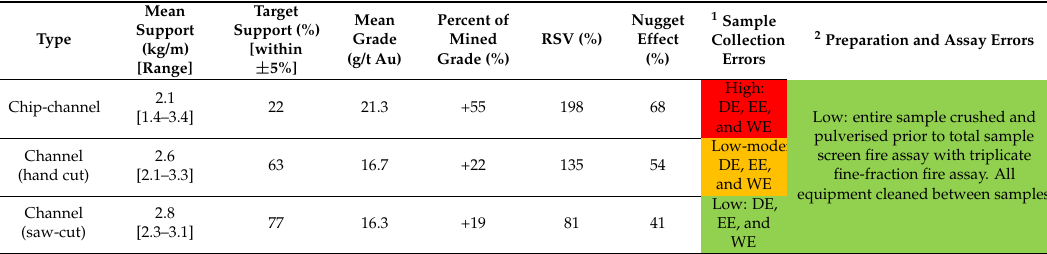
Table 22. Example from an Australian mine showing comparison between chip and channel sample replicates. Total number of samples in each type was 75. Mean grades cut and diluted to stope width. Reconciled stope head grade 13.7 g/t